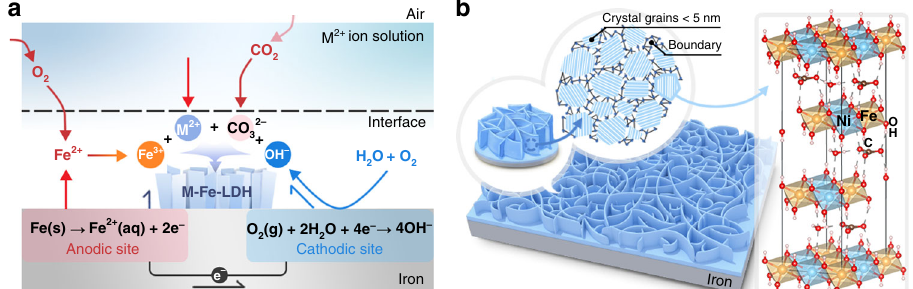
Fig. 1 Schematic illustrations of the formation and microstructure of the electrodes. a The speci fi c reactions happened during the corrosion of iron substrates; and b the formation of grain boundary-enriched layered double hydroxide (LDH) nanosheet arrays on the surface of iron substrates. A representative crystal structure of LDH is also shown in